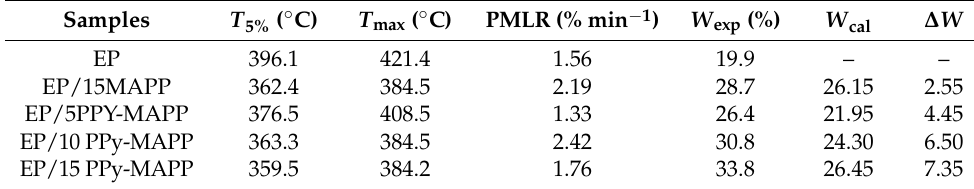
Table 2. Typical thermal data of flame-retarded epoxy resins.